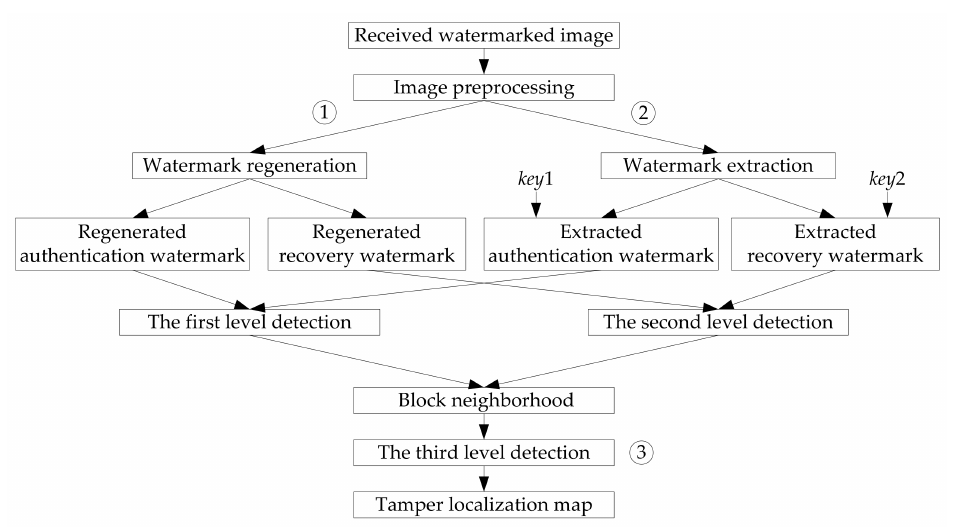
Figure 3. Three-level detection strategy used in this